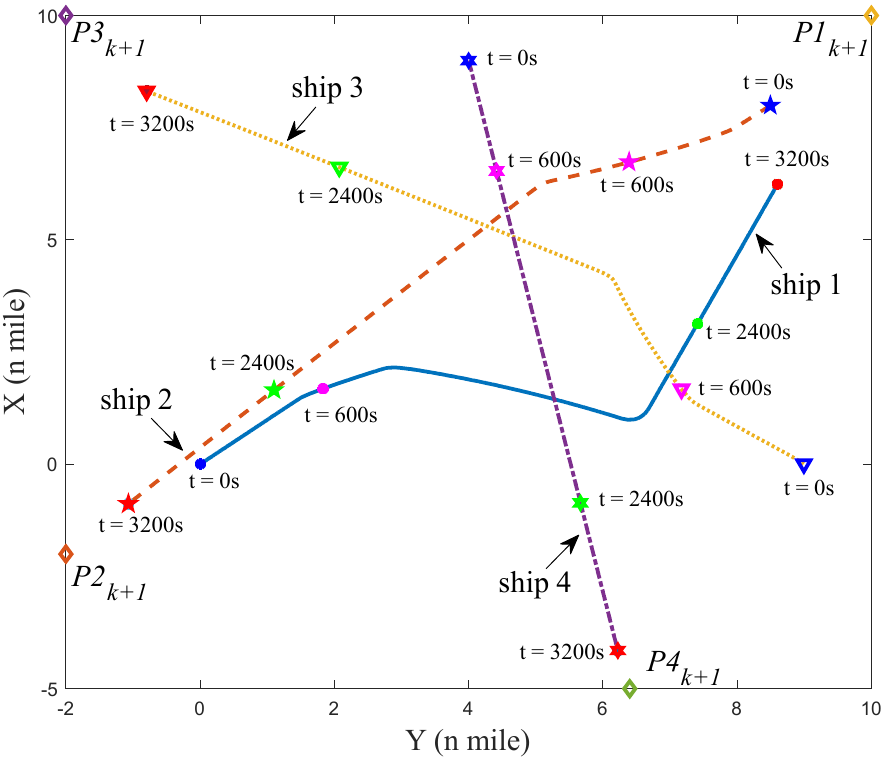
Figure 16. The situation of four ships at t = 3200 s in scenario 2.